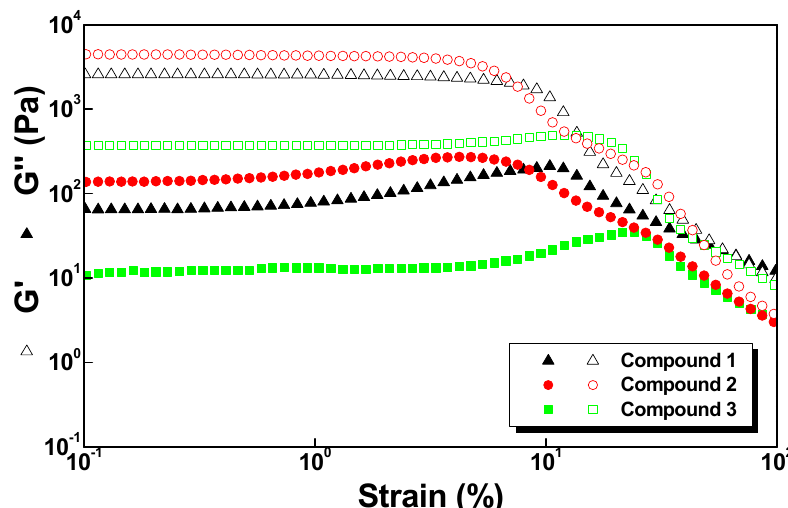
Figure 7. Strain dependence of the shear elastic G ′ (empty symbols) and loss G ″ (filled symbols) moduli for compounds 1 , 2 , and 3 .